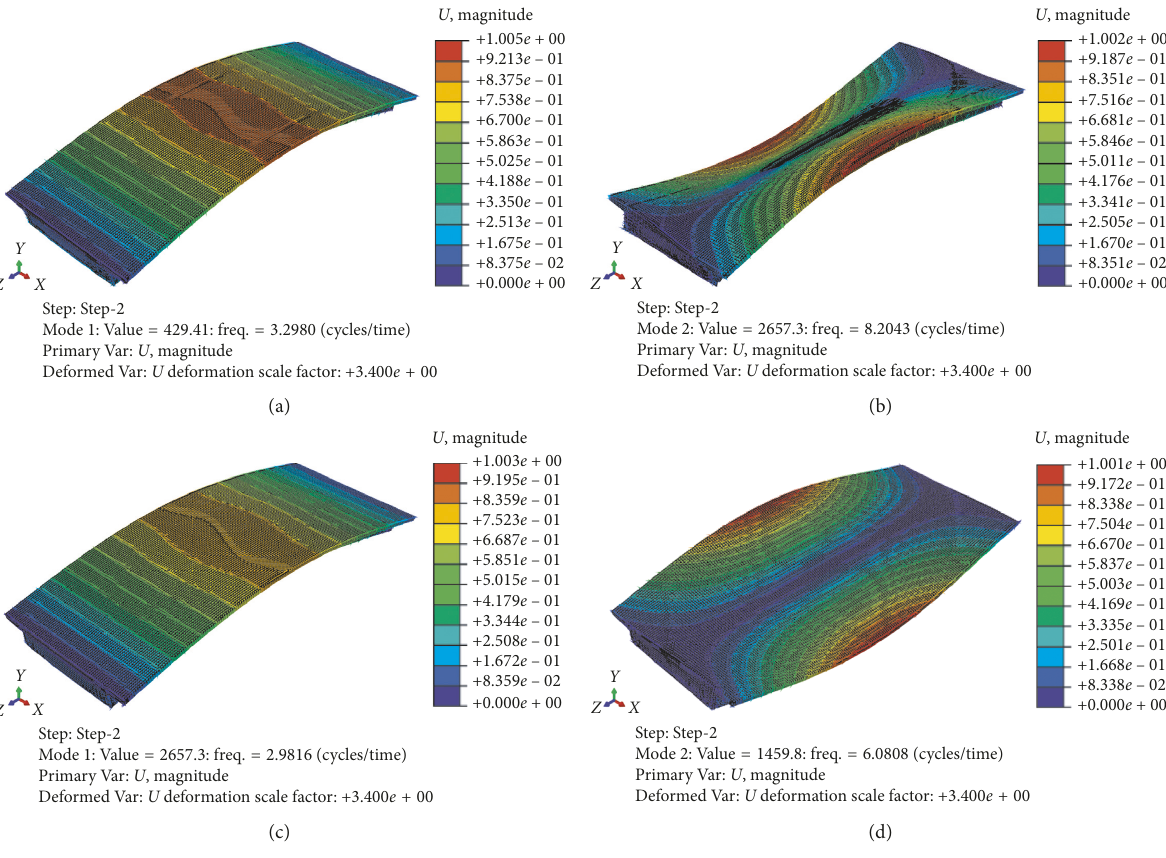
Figure 5: The first two modes of the two models. (a) The first-order mode and (b) the second-order mode of the CWBG bridge. (c) The first- order mode and (d) the second-order mode of the CSWBG bridge. CWBG: concrete web box girder; CSWBG: corrugated steel web box girder.